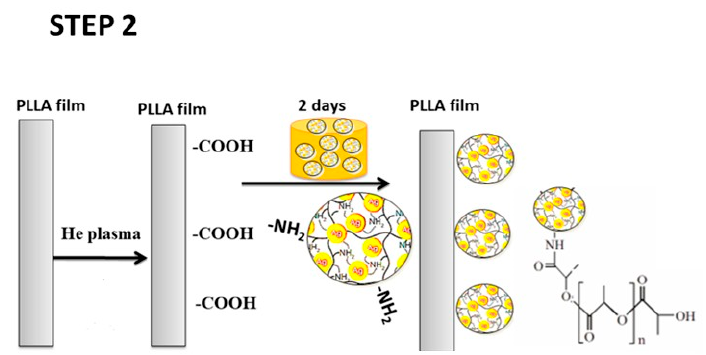
Figure 6. Schematic for the preparation strategy of PLA/AgNPs nanocomposite film.